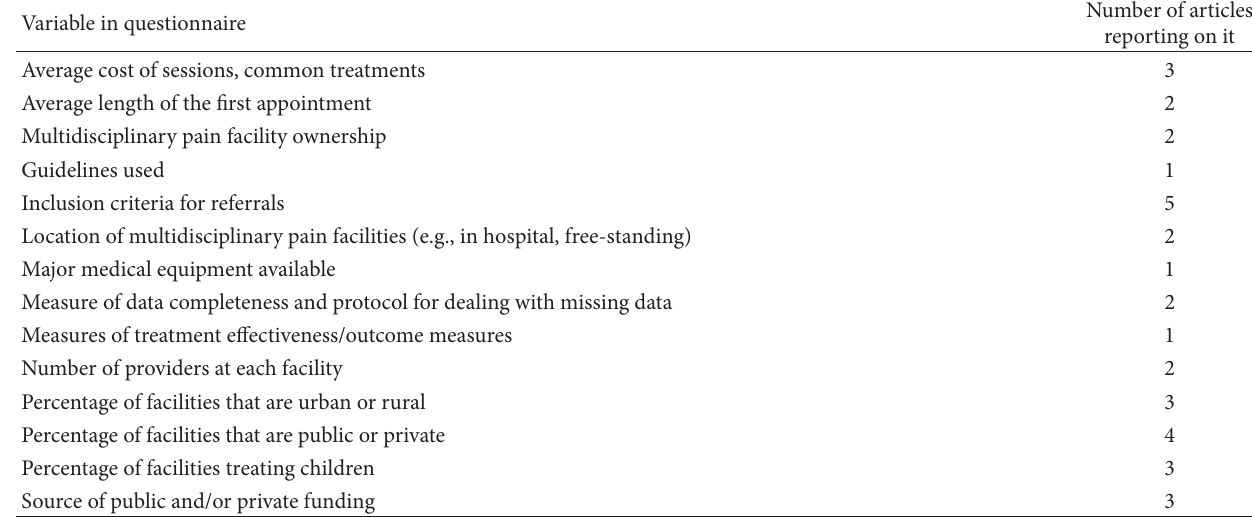
Table 9: Useful but infrequently reported survey